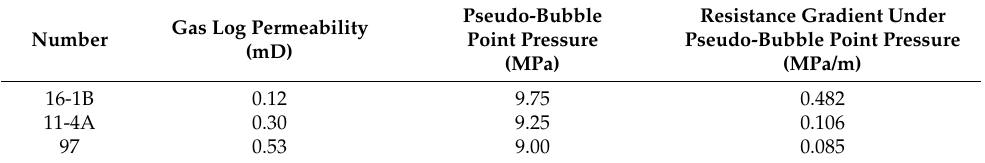
Table 6. Pseudo-bubble point pressures and corresponding resistance gradients of the three Figure 7. Sketch of a stream tube.